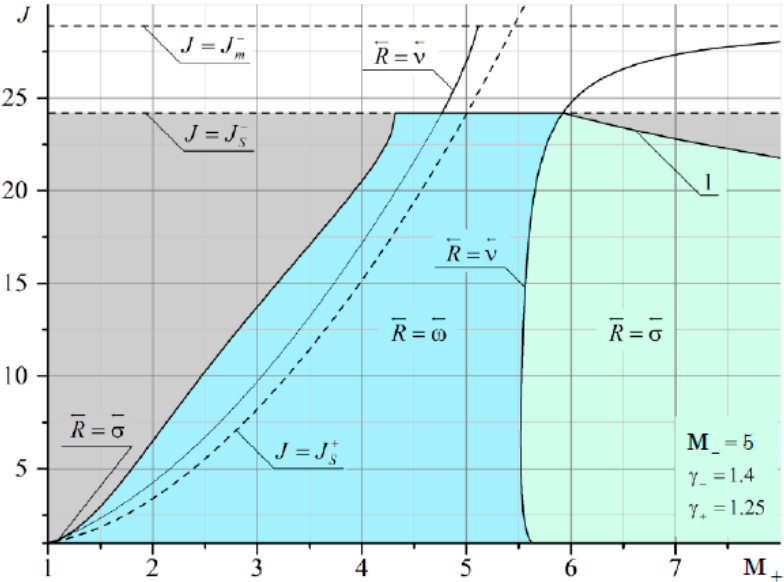
Figure A15. Domains of existence of reflected discontinuities for refraction from a diatomic gas into a gas consisting of combustion products. The Mach number of the flow from which the shock comes is M – = 5. The domains of existence of reflected discontinuities for refraction from a hydro- gen/oxygen mixture at Mach number M – = 3.27 corresponding to Chapman–Judge deto- nation are shown in Figure